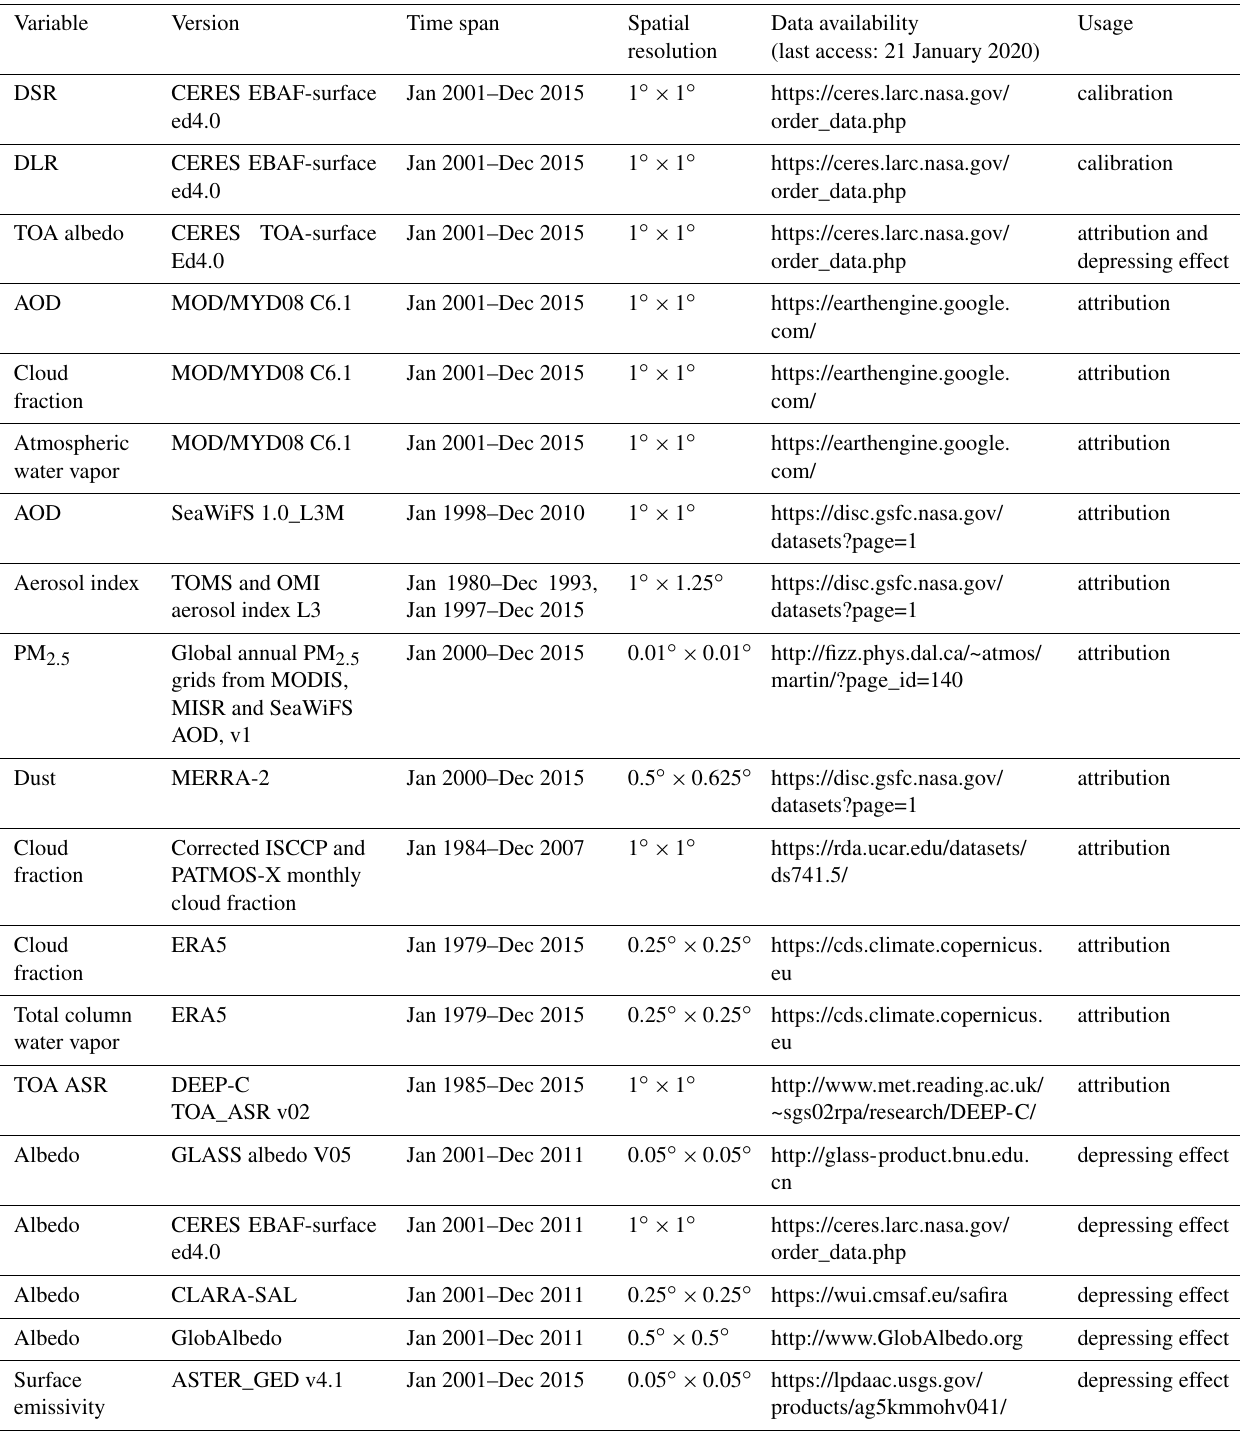
Table 2. Meta information on the satellite and reanalysis products. All products were resampled into 1 ◦ lat/long using bilinear interpolation or spatial averaging in the paper. All data were accessed on 15 December